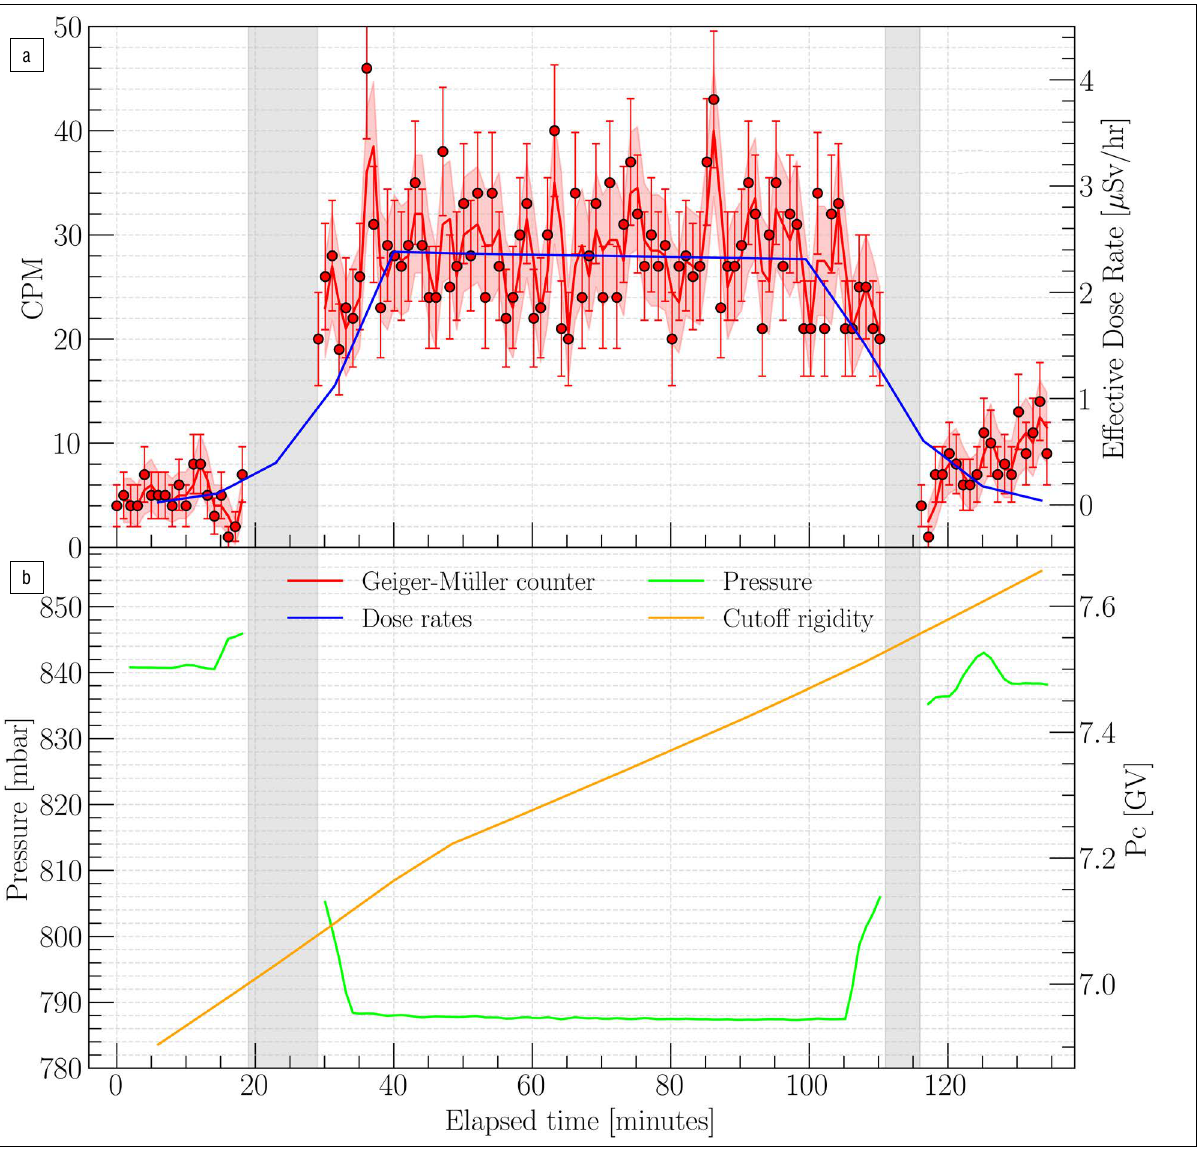
Figure 6: (a) The counts per minute (CPM; red colour) and model dose rates profile (blue colour). (b) Sensor HAT barometric pressure (green colour) and the Pc profile (orange